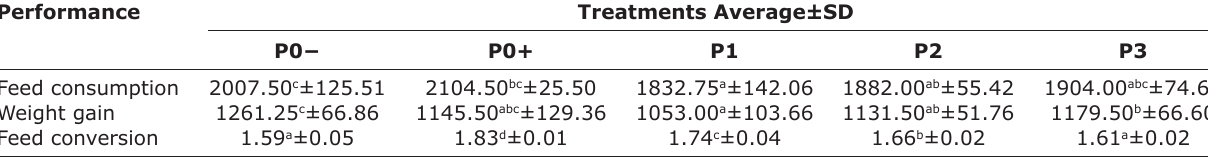
Table-3: Performance of the broilers.